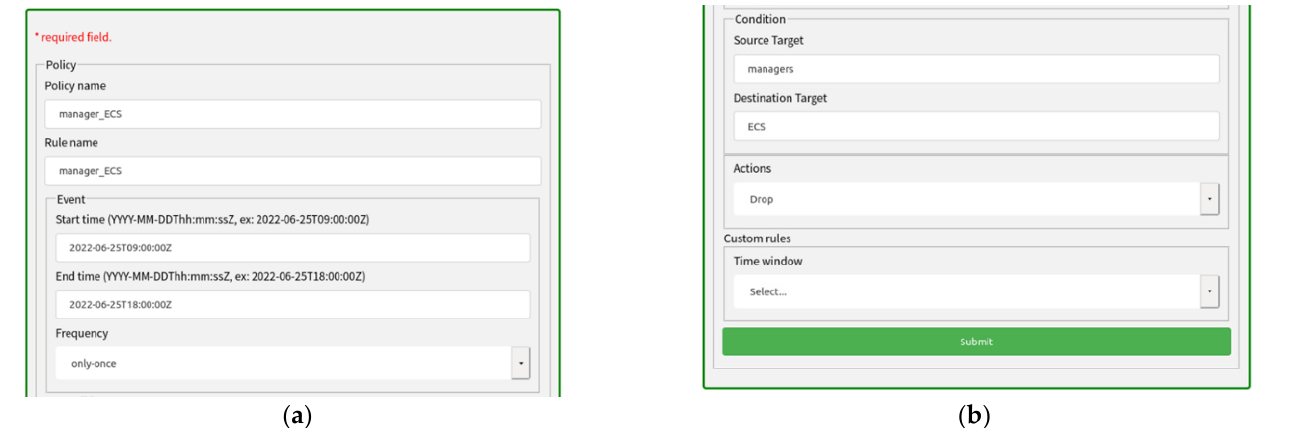
Figure 16. Advanced policy for blocking traffic. ( a ) Policy name and event. ( b ) Condition, actions and custom rules.